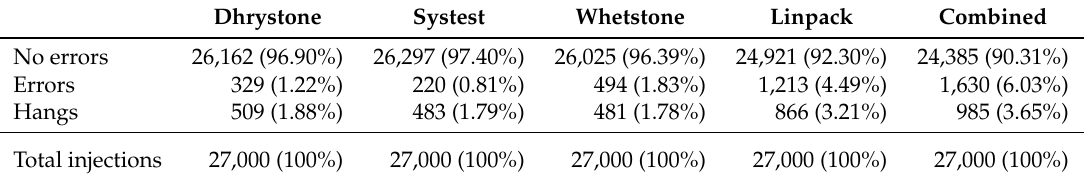
Table 1. Reliability results for the unprotected version of the Rocket RISC-V processor.